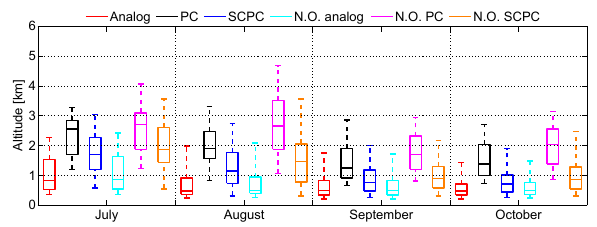
Figure 3. CAPABL binned liquid data from July 2015 to October 2015. The median is indicated by a line through the box, the 25th to 75th percentile ranges complete the box, and the whiskers ex- tend to the 5th and 95th percentiles. PC, SCPC, and N.O. stand for photon counting, saturation-corrected photon counting, and non- orthogonal,